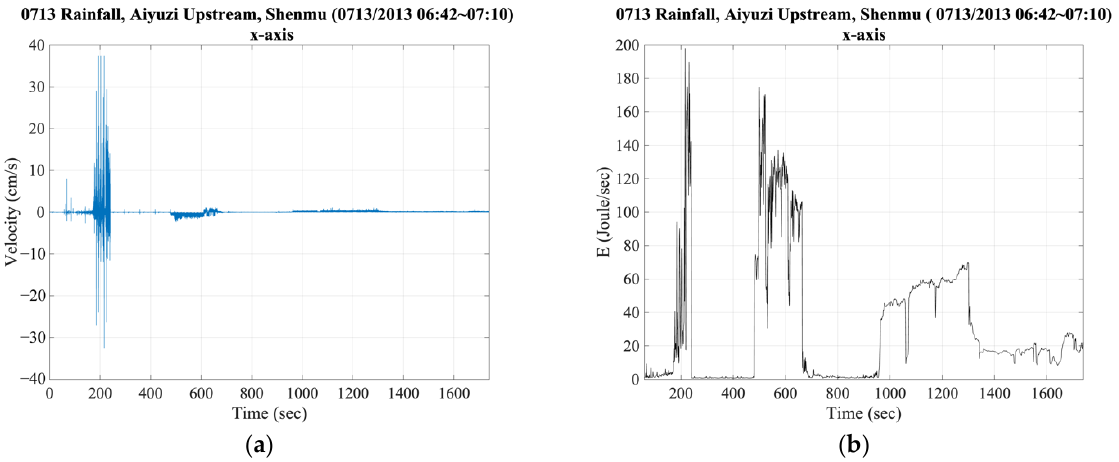
Figure 5. The data of Typhoon Saulik (0713) Rainfall in 2013 ( a ) vibration signals ( b ) accumulated energy per second.